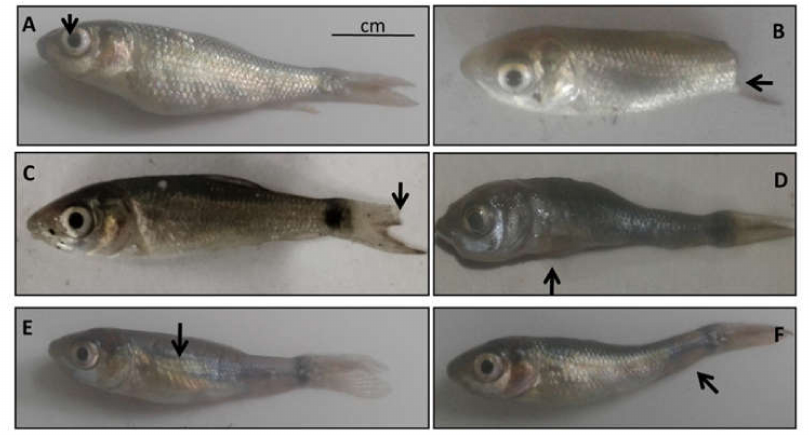
Figure 4. Morphological anomalies and deformities of arsenic-exposed rohu carp. Protrusion eye ( A ), caudal fin erosion ( B , C ), irregular body shape ( D , F ), skin discoloration ( E